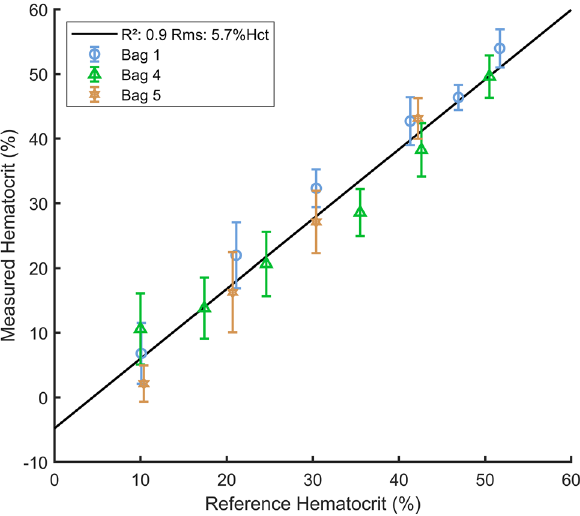
Figure 7. Hematocrit measurement for three different blood bags using the τ